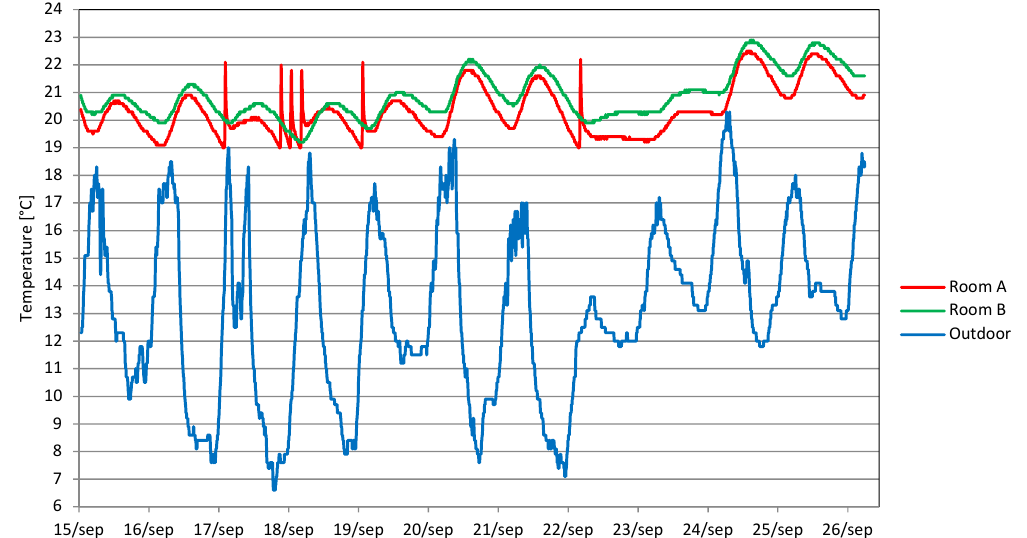
Figure 16. Indoor temperature in room A and room B as well as outdoor temperature from 15–26 September 2017. The second y-axis shows energy use for space heating of room A (room B required no space heating during this period).